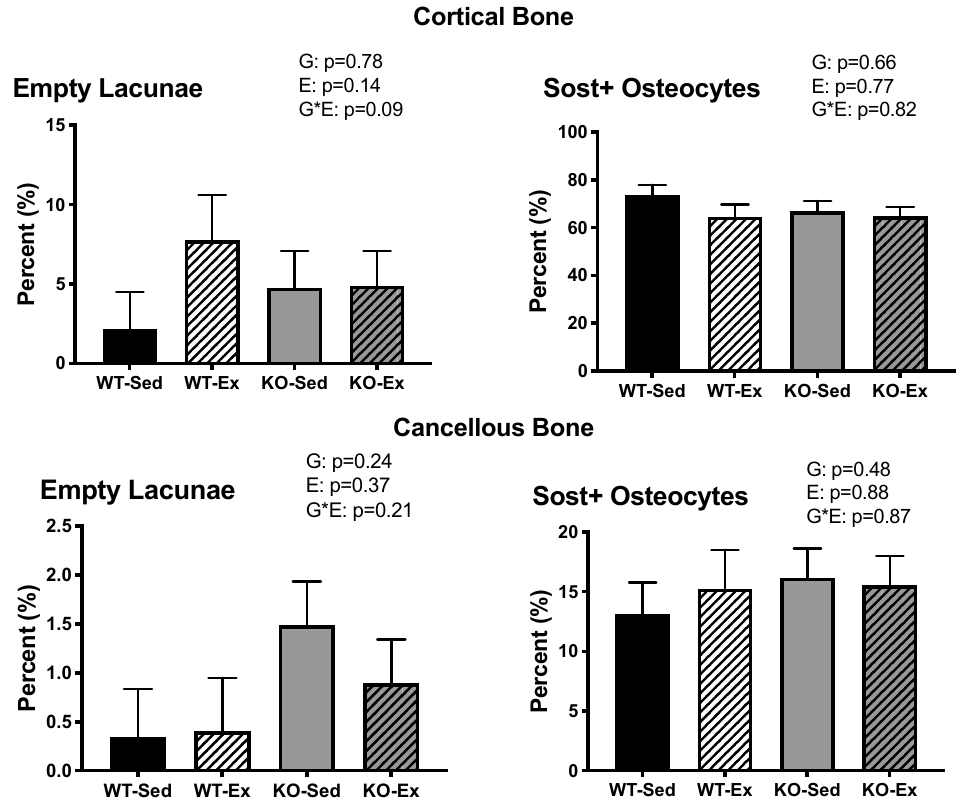
Figure 4. Sclerostin expression. Sclerostin expression of the femur in cortical and cancellous bone. Data are means ± SEM, n = 6–8 per group ERKO: ER α knock out; WT: wild type; Ex: voluntary wheel running; Sed: sedentary.